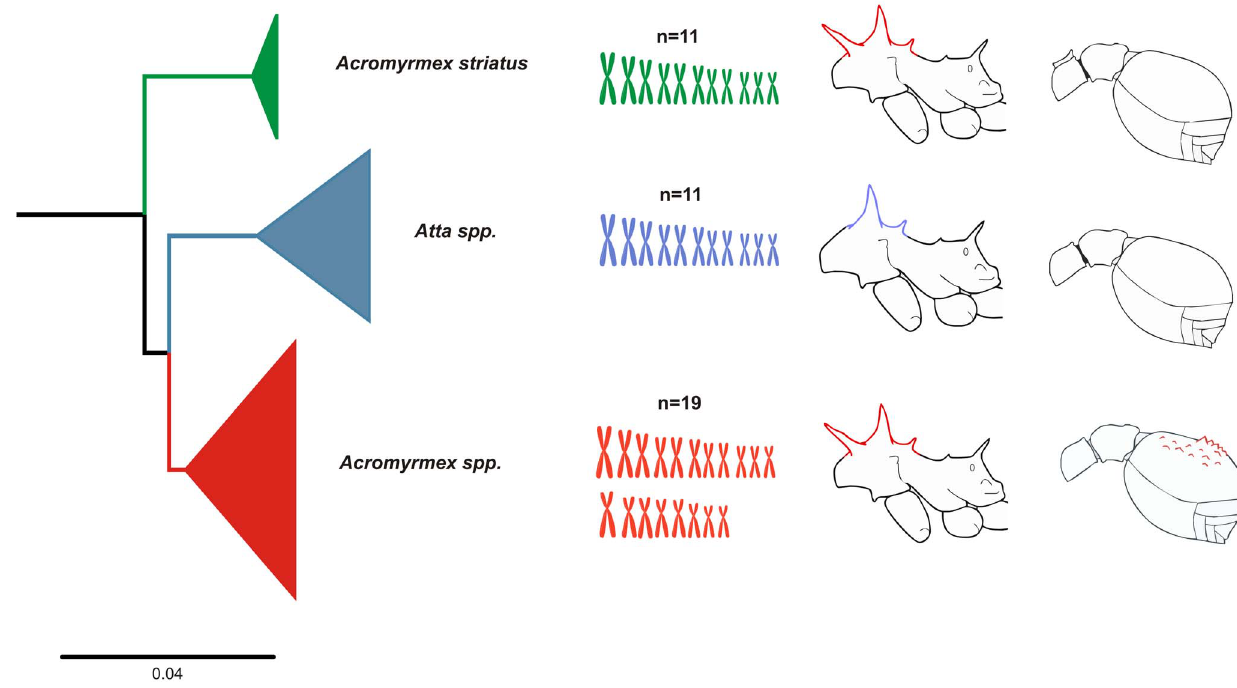
Figure 6. Summary of results in the present and previous studies. From the left to right: Phylogenetic relationship among Acromyrmex striatus , Acromyrmex spp. and Atta ssp. showing A. striatus as a sister group of the reminder leafcutter ants. Ideograms representing the haploid chromosome complement know for each cluster, Atta ssp. and A. striatus shared the haploid number of 11 chromossomes and the majority of metacentric chromosomes. Morphological characters (from description by Mayhe´-Nunes [7]) shared among A. striatus , Atta spp. and Acromyrmex spp., three pairs of spines on promesonotum are beard by A. striatus and Acromyrmex spp, while Atta spp. display two pairs of spines, on the other hand A. striatus and Atta spp. display smooth gastral tergum whereas Acromyrmex spp. has a tuberculate